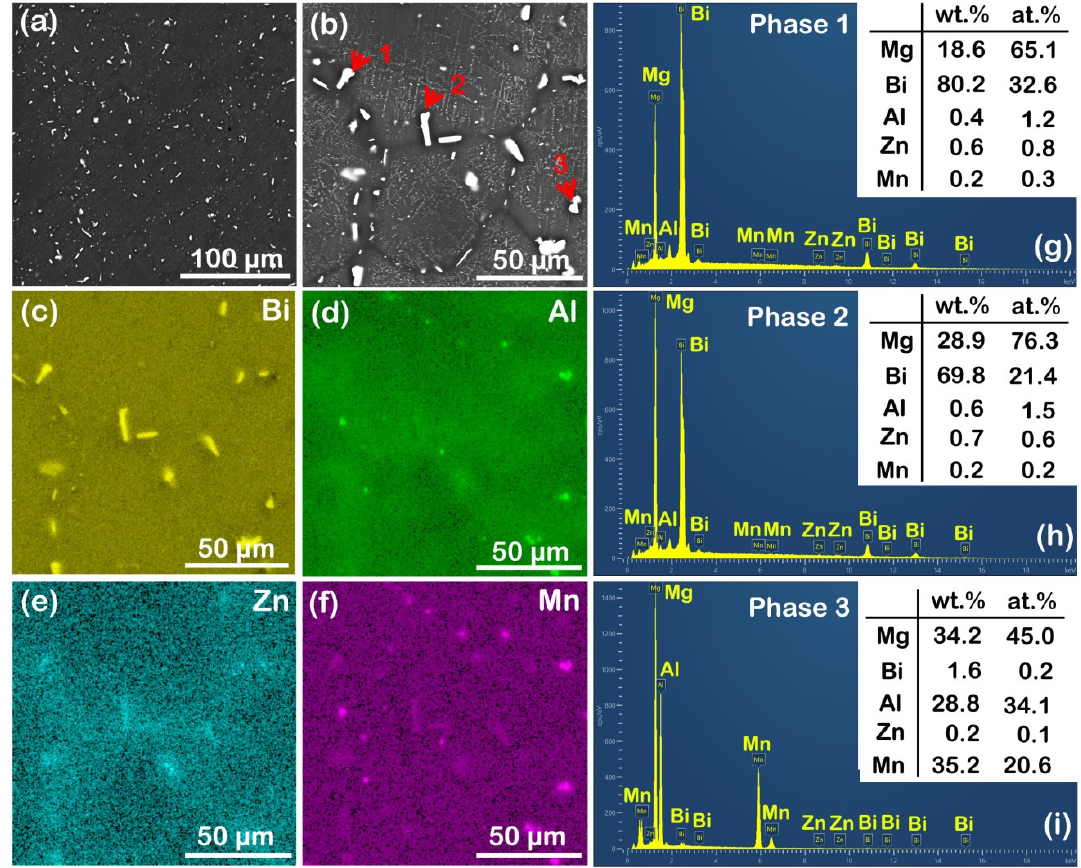
Figure 3. SEM analysis of as-cast AZB313 alloy: ( a ) SEM image; ( b ) magnified SEM image; ( c – f ) SEM mapping results showing Bi, Al, Zn, and Mn distributions; ( g – i ) SEM point scanning results of phases 1–3 marked by red arrows in ( b ), respectively.